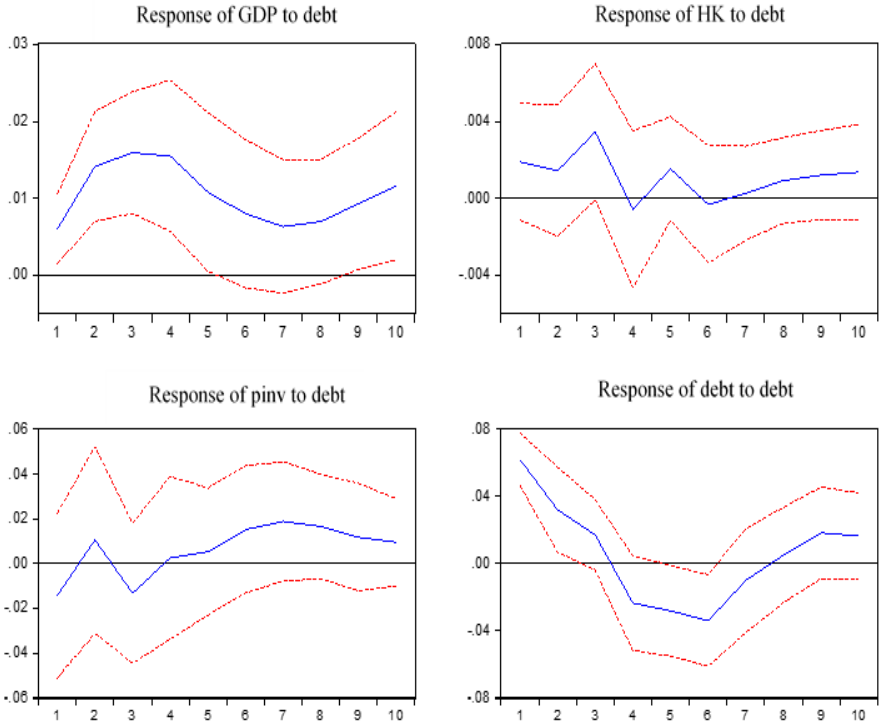
Figure 5: Response of government debt, priate investment, per capita output and human capital stock to a generalized 1 SD innovation in government debt, Philippines,